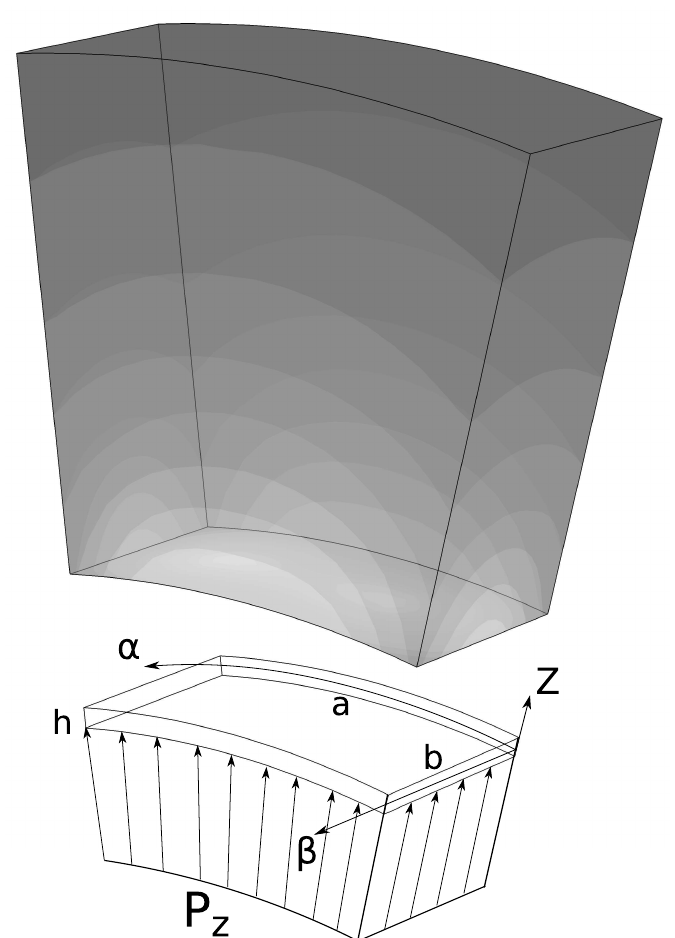
Figure 3. Cylindrical shell reference system, its geometry, the external load sound pressure wave and the transmitted sound pressure field.